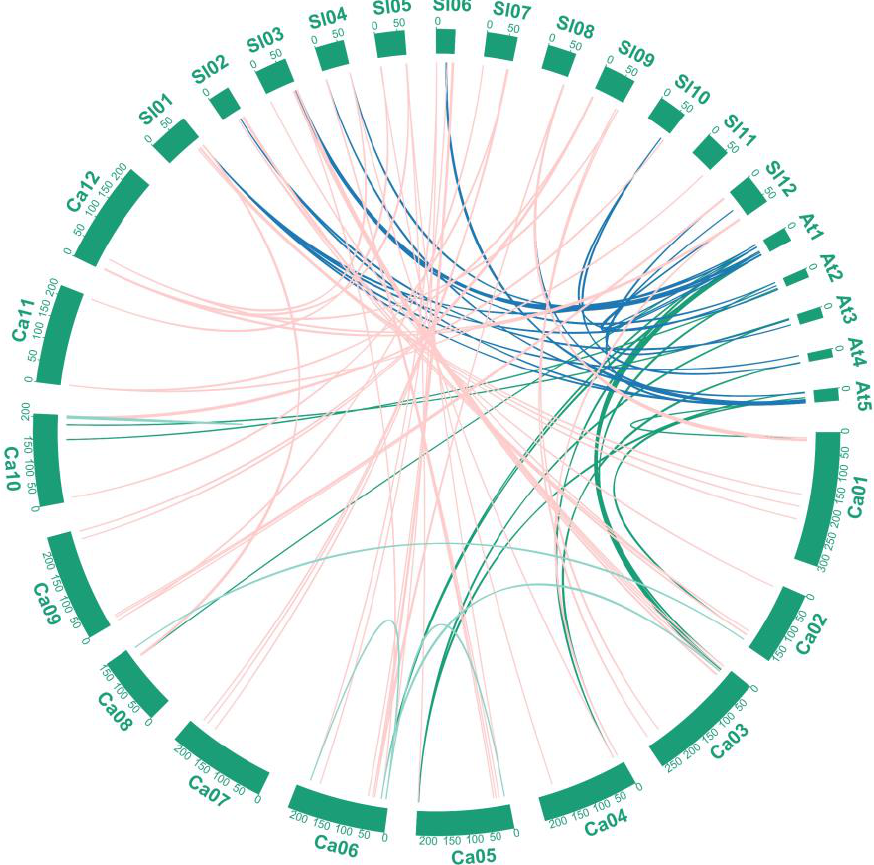
Figure 2. Collinear analysis of CaMYB -related genes among pepper (Ca), Arabidopsis (At), and tomato (Sl). Blue, green, pink, and blue-green lines represent the collinear gene pairs between chromosomes of tomato and Arabidopsis , Arabidopsis and pepper, tomato and pepper, and pepper and pepper, respectively. Chromosome numbers are located above the chromosomes.